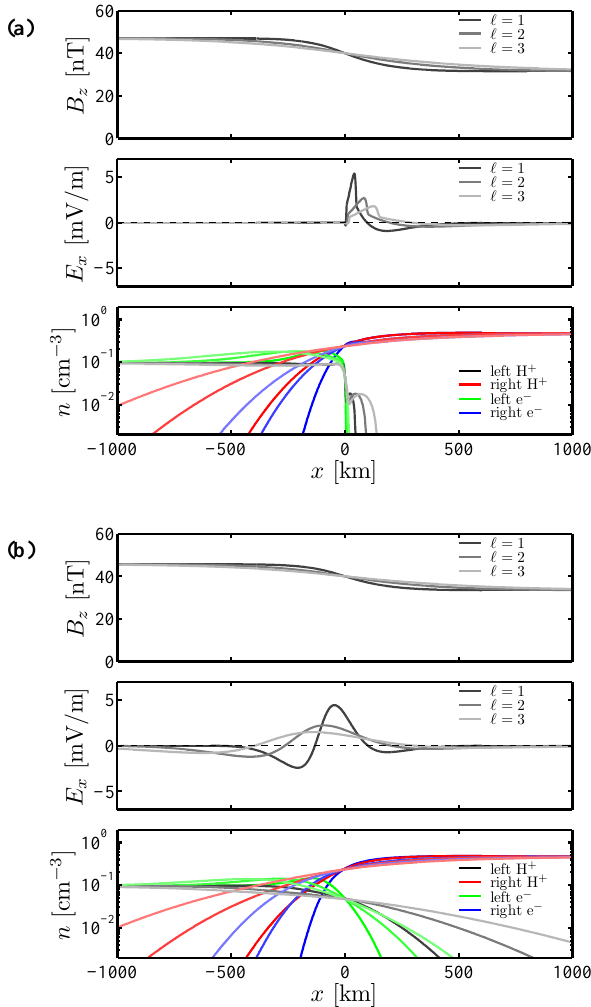
Fig. 3. Structure of a tangential discontinuity for (a) a cold–hot plasma interface between a 1eV electron and 5eV proton plasma with density 0 . 1cm − 3 on the left side and a 1keV electron and 5keV proton plasma with density 0 . 5cm − 3 on the right, and (b) a hot–hot plasma interface between two 1keV electron and 5keV pro- ton plasmas with densities 0 . 1cm − 3 on the left side and 1cm − 3 on the right. The top panels show the magnetic field profile across the structure ( B z component; the field is unidirectional along z ), the middle panels give the electric field, and the bottom panels plot the densities of the four plasma populations involved. The solutions are obtained for zero external electric potential difference across the discontinuity and in the absence of flow shear. The compu- tations have been carried out for dimensionless transition lengths ‘ = ‘ + = 1, 2, 3 and the corresponding values ‘ − = 40, 80, 120.